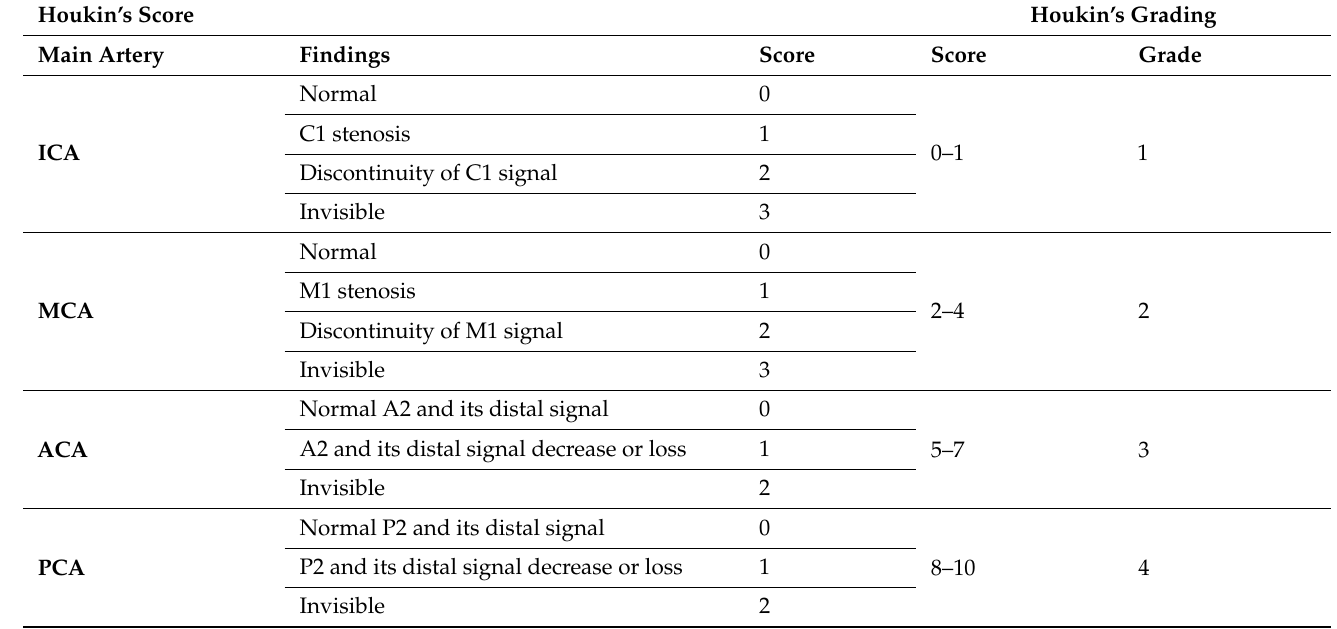
Table 2. Houkin’s MRA score and grading [50].